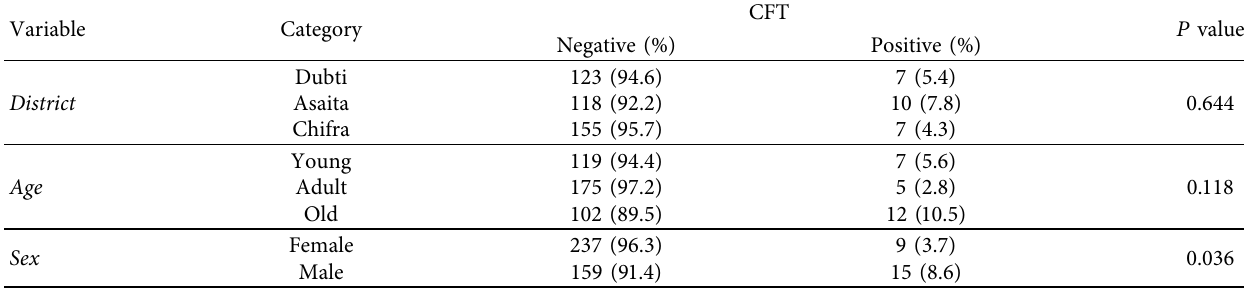
Table 1: Descriptive variables against the disease (CFT